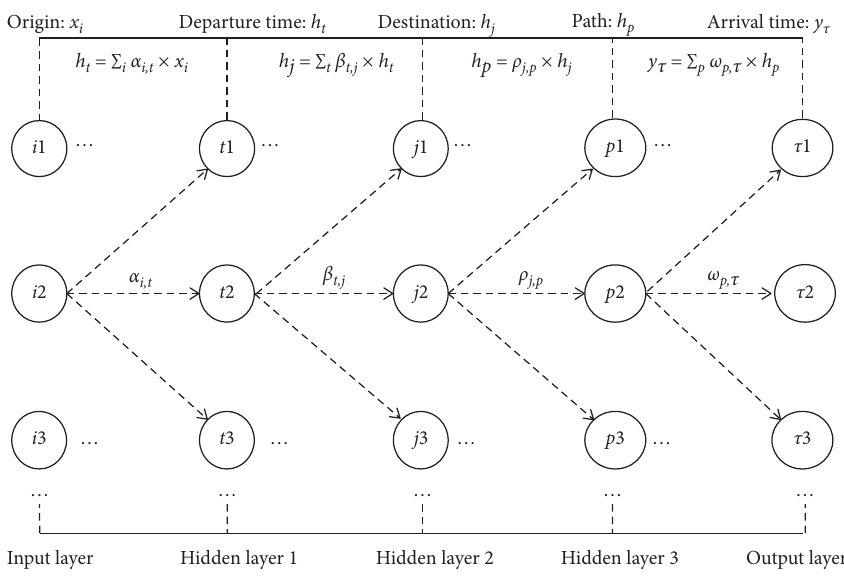
Figure 4: The forward passing process of the TDHFN. Table 2: Algorithm